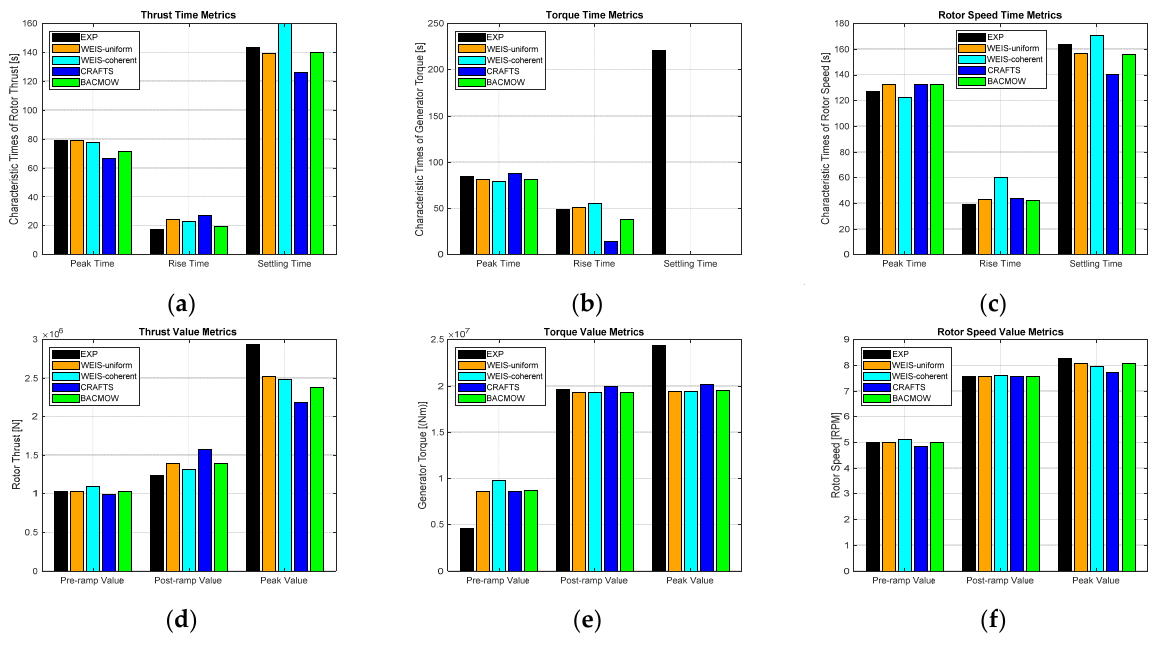
Figure 13. LC 3.2 time metrics ( a – c ) and value metrics ( d – f ) for thrust, torque, and rotor speed.